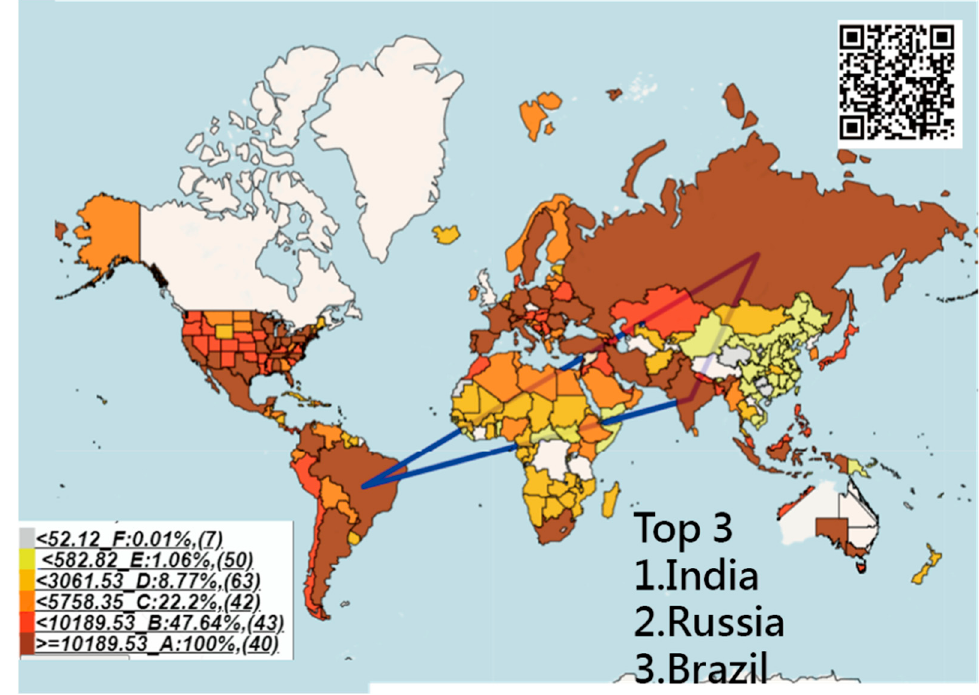
Figure 2. The density of the IPcase index used to measure the SACOVID on countries/regions in the world.